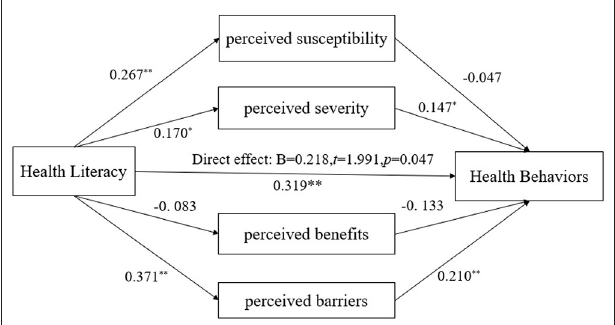
FIGURE 2 | A mediation model of health beliefs between health literacy and health behaviors. The model has adjusted for age, gender, marital status, chronic conditions, and education levels. * p < 0.05, ** p <